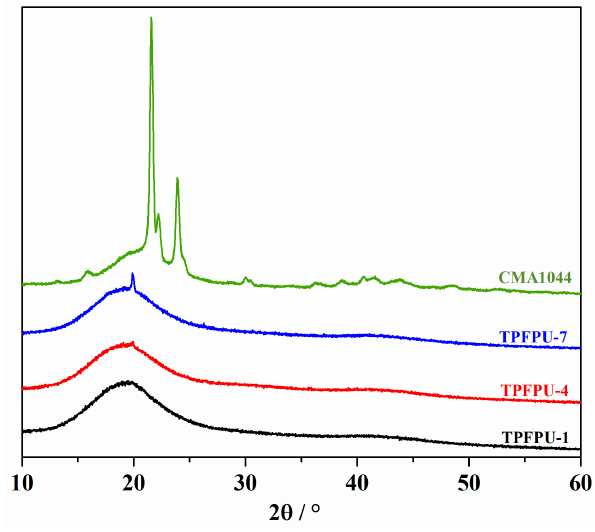
Figure 8. XRD pattern of the TPFPU and the CMA-1044.